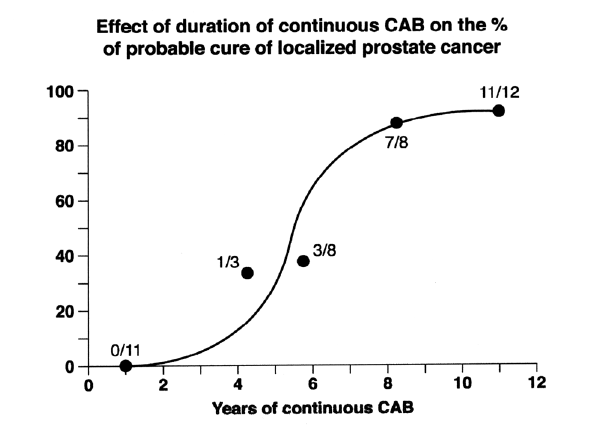
Figure 4 – Effect of duration of treatment of localized prostate cancer with continuous combined androgen ablation (CAB) on the probability of long term control or “cure of the disease” il- lustrated by no recurrence of PSA rise for at least 5 years after cessation of CAB. The point at 4.75 years of treatment (33%) refers to the 3 patients treated with CAB for 3.5-5.0 years and followed for at least 5 years, while the point at 5.75 years refers to the 8 patients treated continuously with CAB for 5.0-6.5 years before cessation of treatment. The point at 8.25 years refers to the 8 patients treated continuously for 6.5-9.0 years while the point at 11 years refers to the 13 patients treated for 10-11.7 years with continuous CAB before stopping treatment. All pa- tients were followed for at least 5 years after cessation of con- tinuous CAB or until PSA rise. Only 1 patient has died from pros- tate cancer while 18 have died from other causes. (From Labrie F, Candas B, Gomez JL, Cusan L: Can combined androgen block- ade provide long-term control or possible cure of localized pros- tate cancer? Urology. 2002; 60: